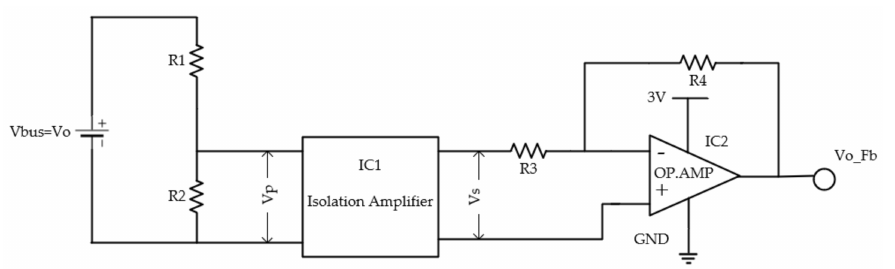
Figure 19. Block diagram of the designed isolated DC voltage sensor (V.S